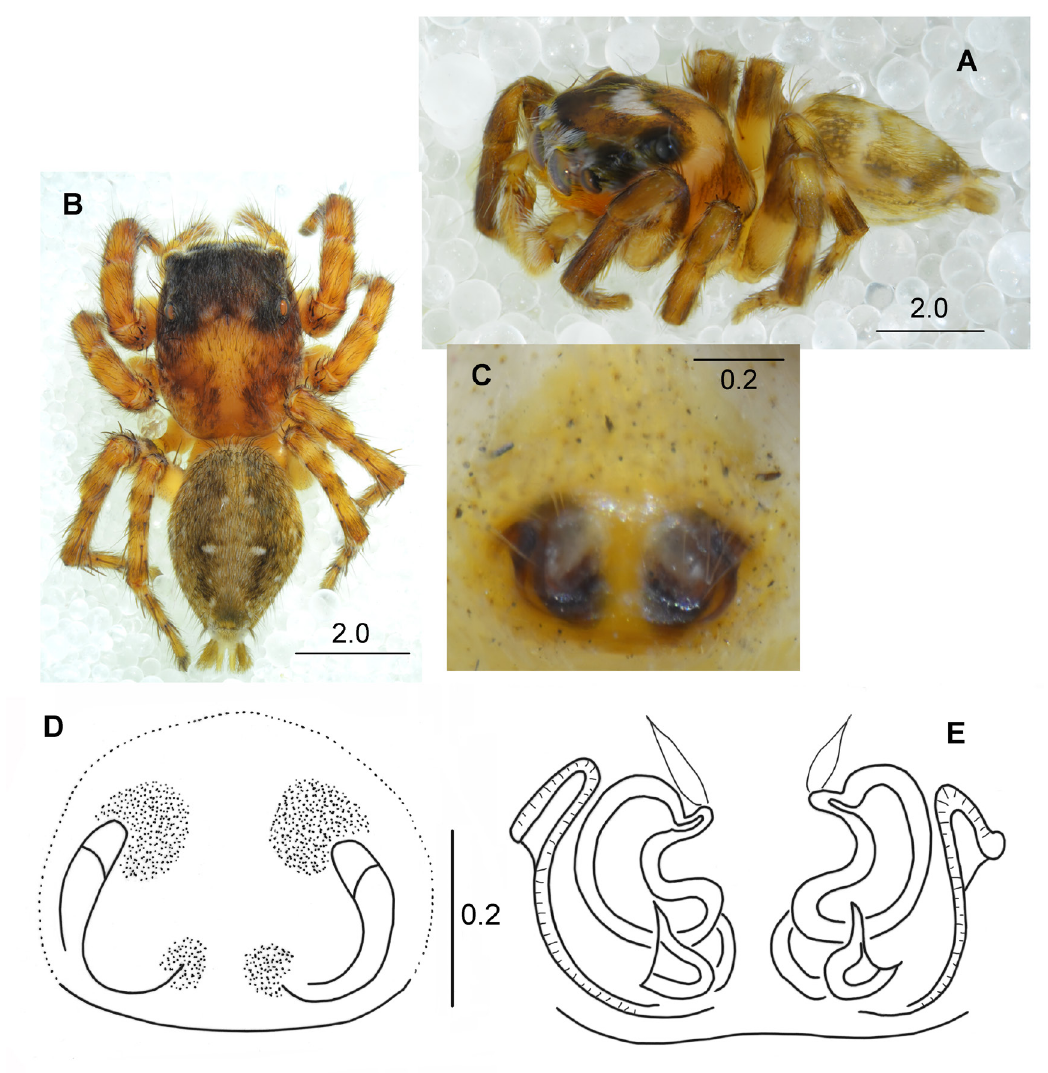
Fig. 16. A . Evarcha bakorensis Rollard & Wesołowska, 2002, ♂ (MNHN). B–E . Evarcha zougoussi sp. nov., holotype, ♀ (MNHN). A . Habitus of male, lateral view. B . Habitus of female, dorsal view. C–D . Epigyne. E . Internal structure of